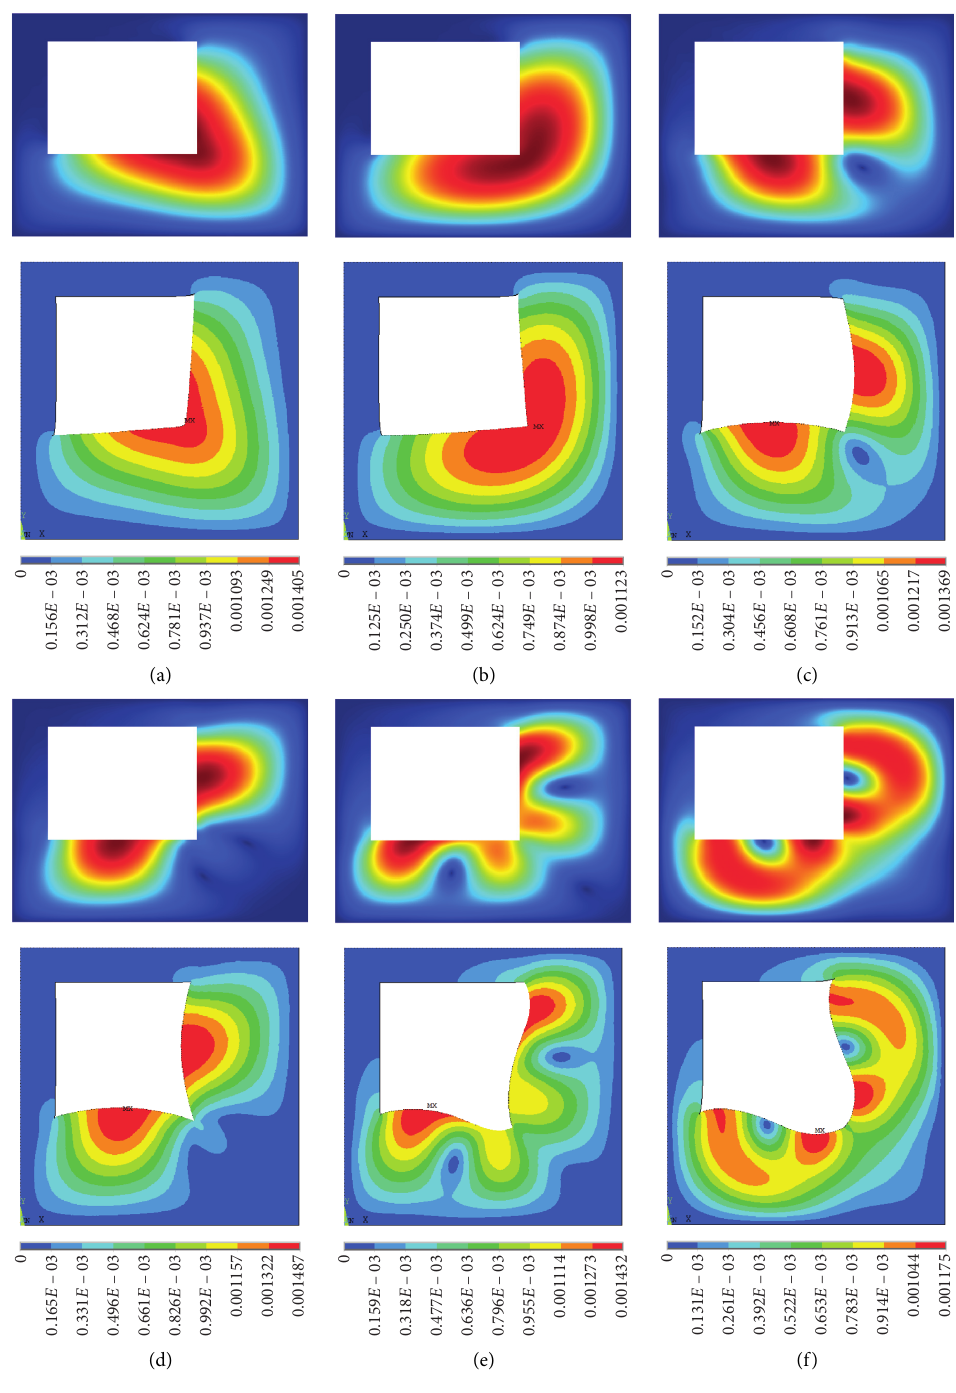
Figure 7: The first six mode shapes for the square plate with a cutout whose size is 20m × 20 m. (a) The first mode; (b) the second mode; (c) the third mode; (d) the fourth mode; (e) the fifth mode; (f) the sixth mode. Upper: the present results; lower: the ANSYS